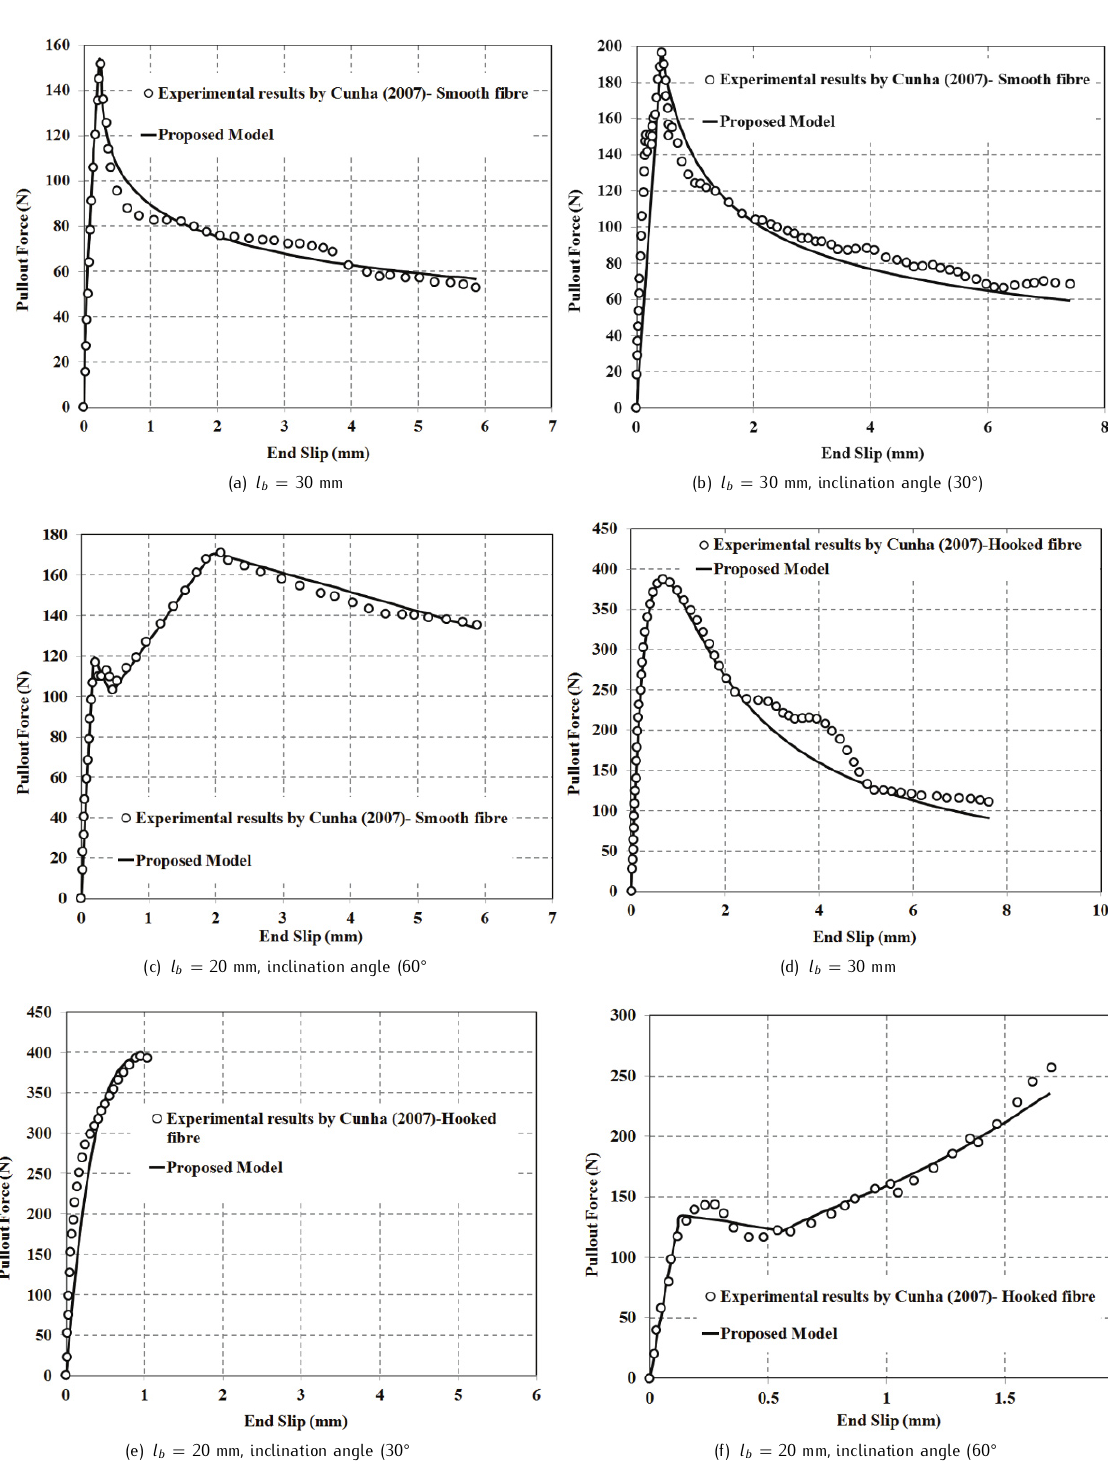
Figure 12. Comparison of the experimentally obtained load-slip curves (Cunha [29]) versus the predicted curves by using the proposed